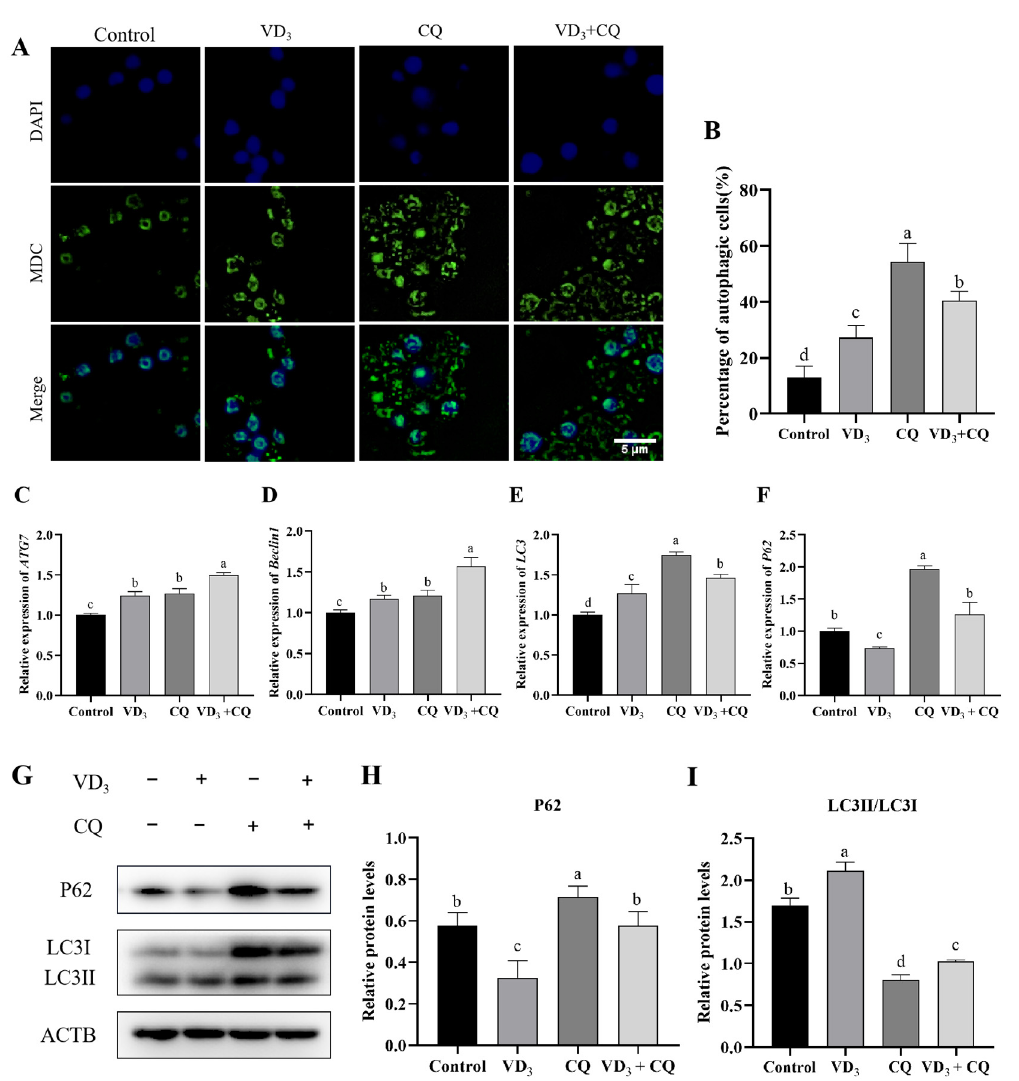
Figure 4. 1 α ,25(OH) 2 D 3 induces PGC autophagy. ( A ) MDC was used to label autophagic vacuoles (green fluorescence) in PGCs, and the statistical results of the percentage of autophagic PGCs ( B ). The relative gene expression of ATG7 ( C ), Beclin1 ( D ), LC3 ( E ), and P62 ( F ) in PGCs. Western blotting was used to identify the protein level ( G ), and the protein contents of P62 ( H ) and LC3II/I ( I ) were evaluated in PGCs. Blue fluorescence represented the nucleus. Bar = 5 µ m. VD 3 : 1 α ,25(OH) 2 D 3 . CQ: chloroquine. Different letters on the bar indicate a significant difference. Data are means ± SE of three independent replicates ( p < 0.05).